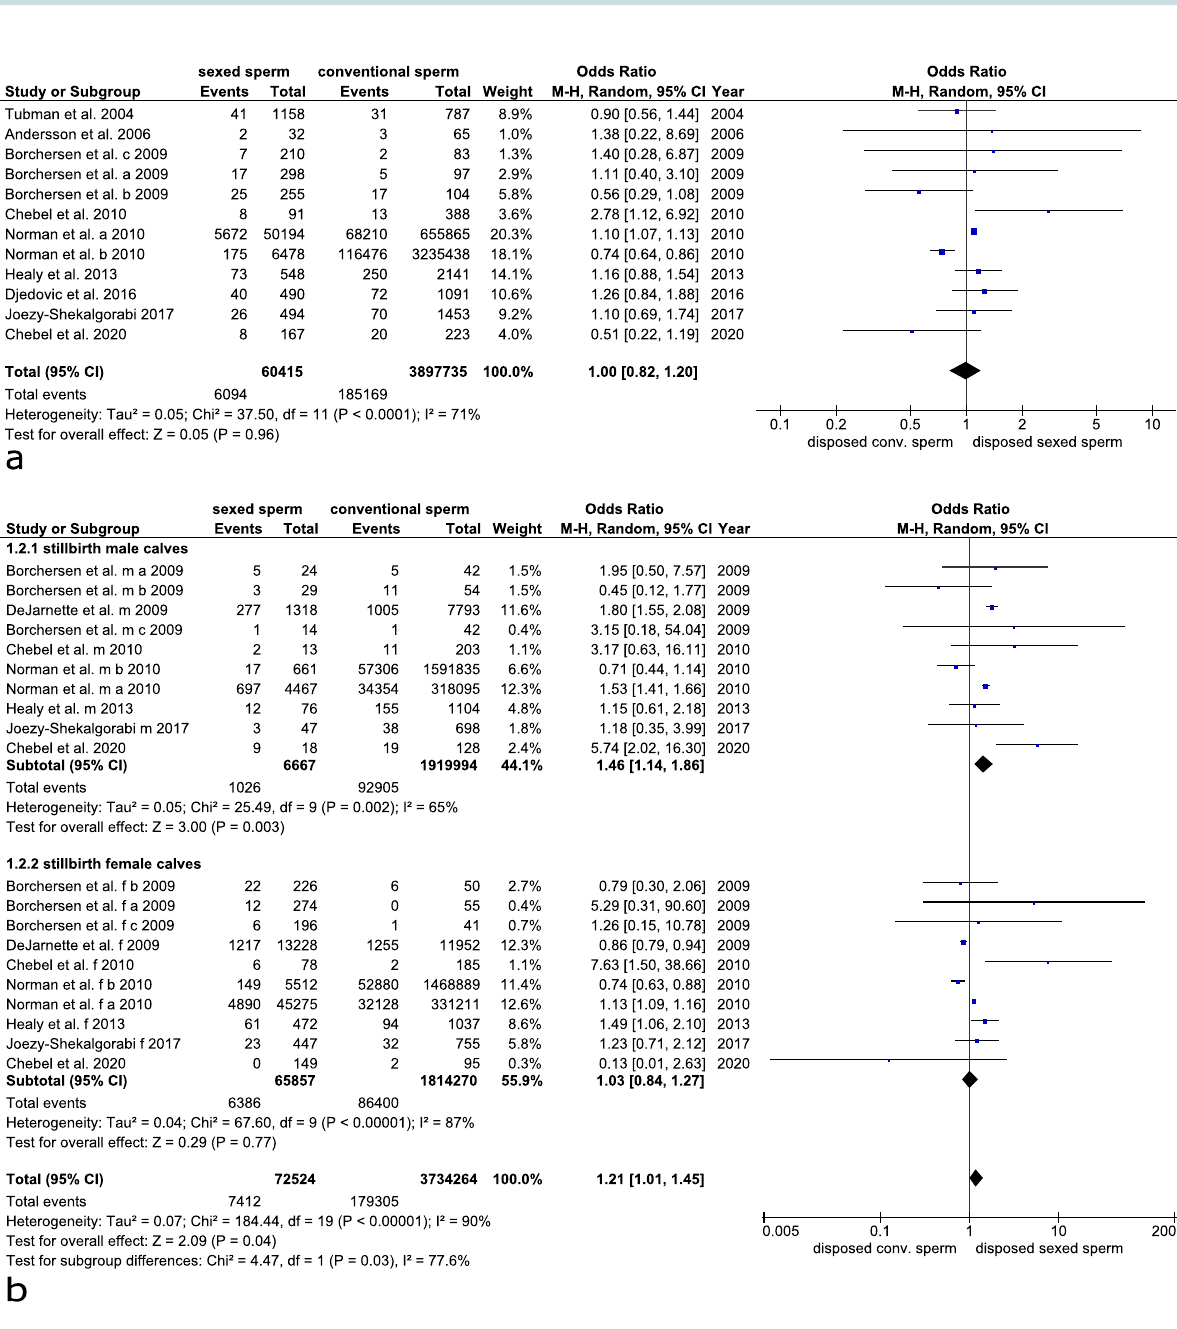
Figure 8. Forest plot of the stillbirth rates after the use of sex-sorted sperm compared to conventional sperm. ( a ) Forest plot including all stillbirths ( b ) Forest plot discriminating between the stillbirth of male and female